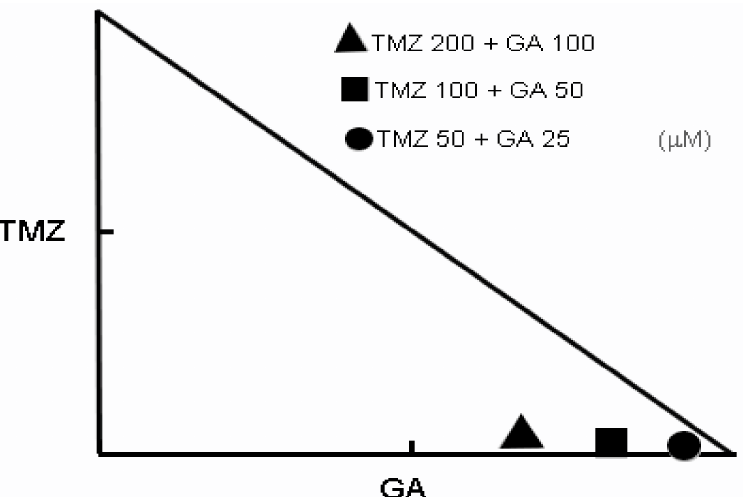
Figure 2. Isobologram analysis of Ga and TMZ co-incubation in U87MG cell line. CI data were computed by CalcuSyn software. Points under the backslash line imply synergestic effect. The trials were conducted at least 3 times. An illustrative trial is